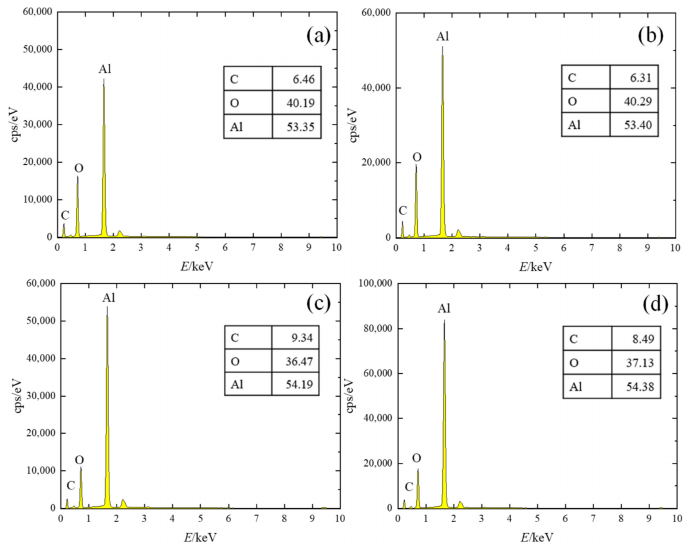
Figure 8. Distribution of elemental content of alumina surface before and after polishing. ( a ) 0#, original surface, ( b ) 1#, normal temperature, ( c ) 2#, preheating 450 ◦ C, ( d ) 3#, preheating 900 ◦